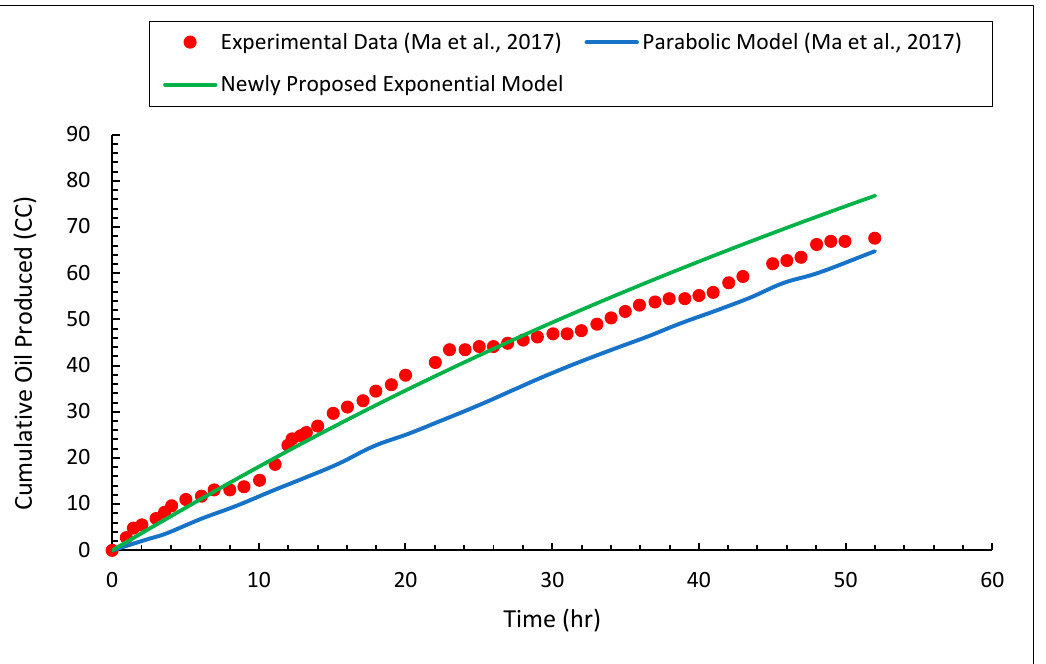
Figure 24. Comparison of the cumulative produced oil estimated by the newly proposed exponential model, experimentally measured cumulative produced oil [3], and cumulative produced oil estimated by the parabolic model proposed by Ma et al. [3] in test #4.